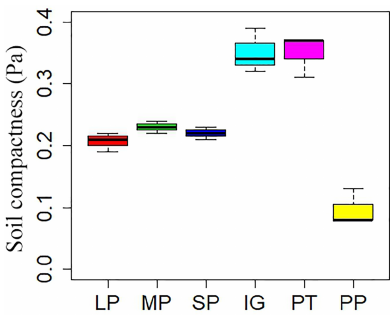
Figure 6. Soil compactness in different surface types: (1) large bald patch (LP), (2) medium bald patch (MP), (3) small bald patch (SP), (4) intact grassland patch (IG), (5) above pika tunnel (PT) and (6) old pika pile